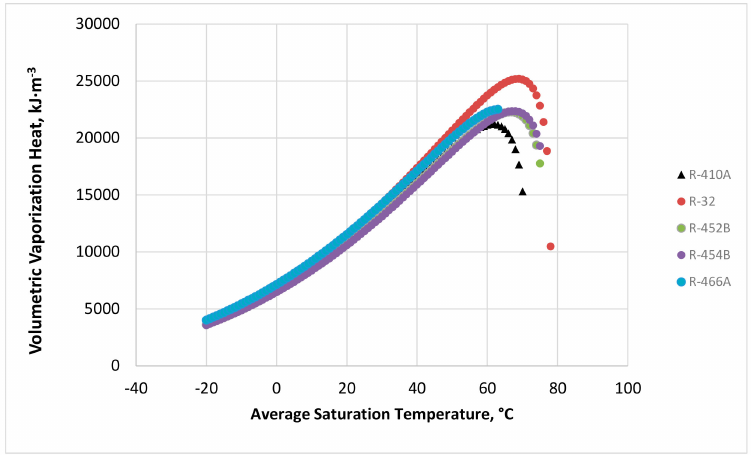
Figure 2. Volumetric heat of vaporization of refrigerant R410A and alternatives.